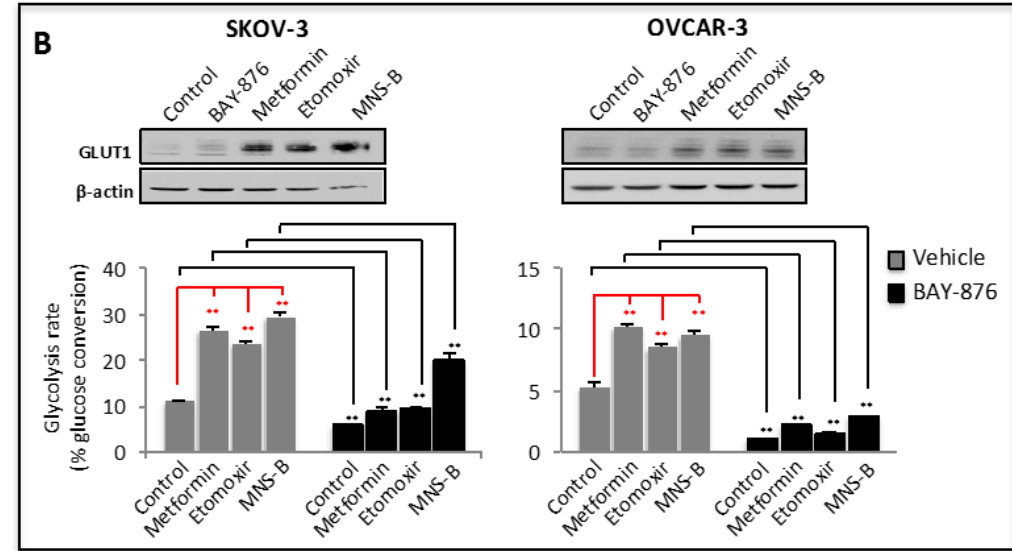
Figure 2. GLUT1 mediates hypoxia- and energy stress-induced glycolysis. Ovarian cancer cell lines were treated for 24 h with CoCl 2 (150 µM) in the presence or absence of BAY-876 (75 nM) ( A ). In ( B) , Ovarian cancer cell lines were treated for 24 h with vehicle, metformin (2 mM), etomoxir (0.25 mM), or MNS-B (50 nM) in the absence or presence of BAY-876 (75 nM). Expression of GLUT1 and HIF-1 α proteins was analyzed by immunoblotting. Glycolytic rates were quantified as in Figure 1. The statistical significances of glycolytic induction and BAY-876-dependent inhibition were indicated with red and black asterisks, respectively. n.s.: * p < 0.05; ** p < 0.01.